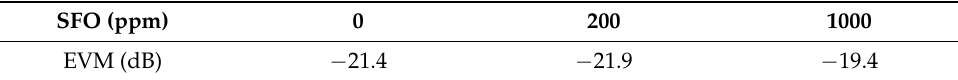
Figure 7. Physical device diagram. ( a ) Oxygen pump; ( b ) Water surface with bubble volume of 16 L/min. Table 2. The EVM performance of different